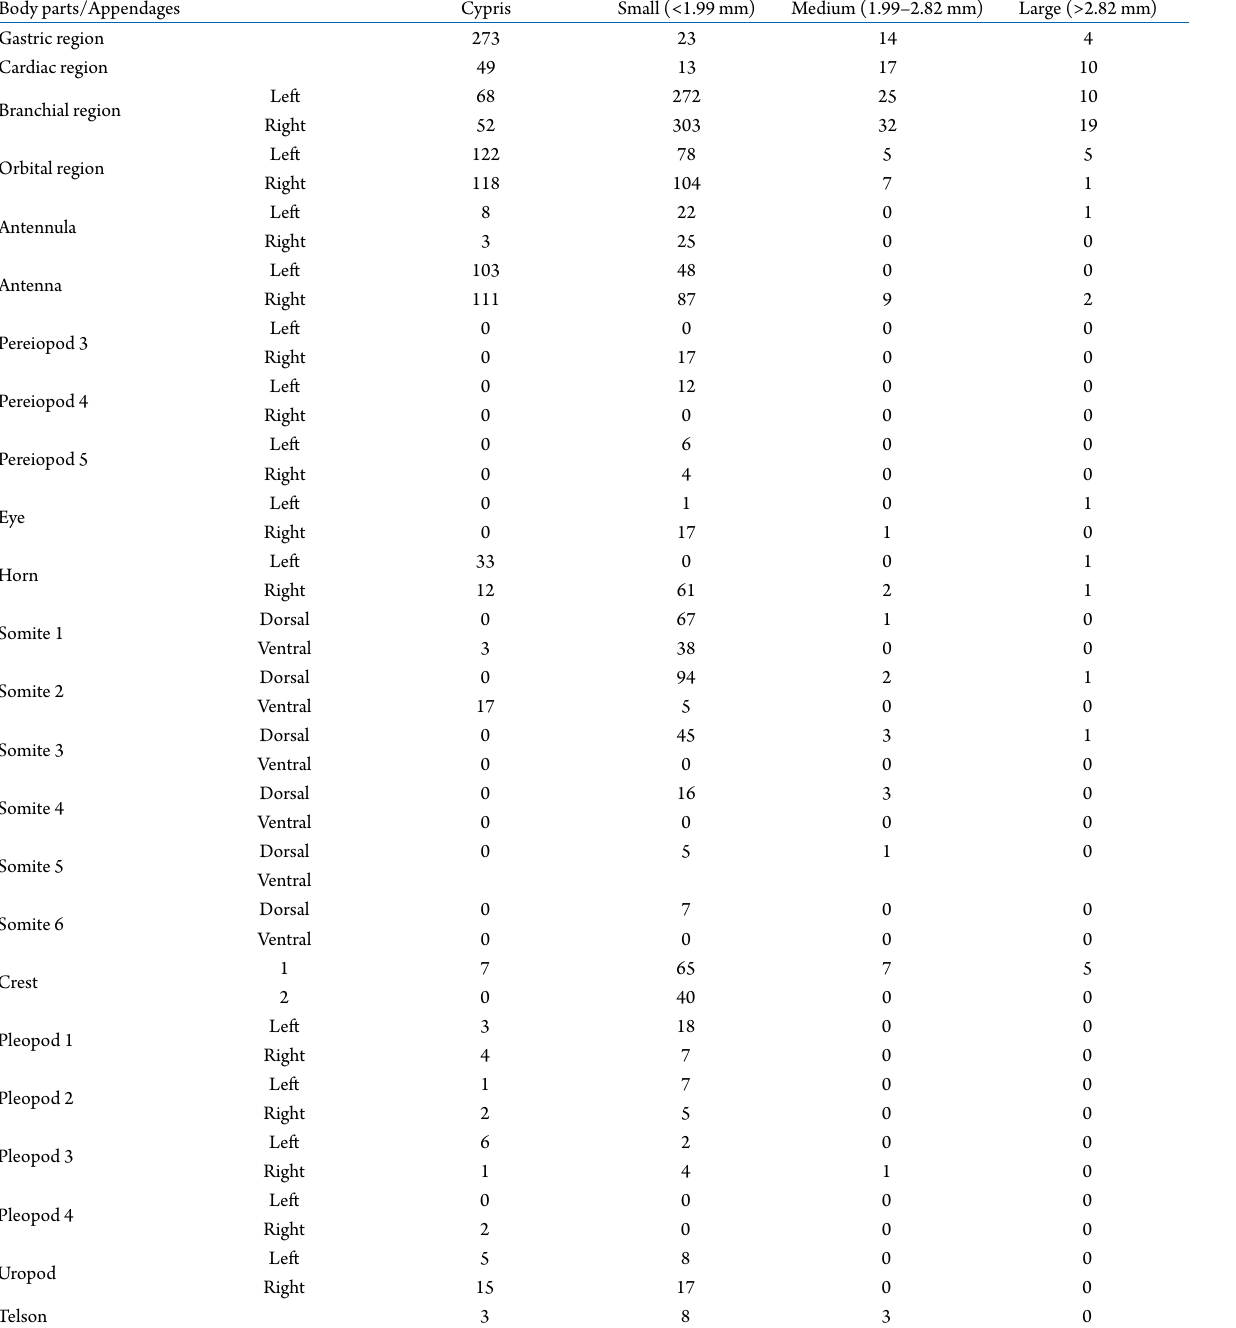
Table 1 . Distribution of Balanus trigonus Darwin, 1854, in different body parts and appendages of Palinurus gracilis Streets, 1871. Body